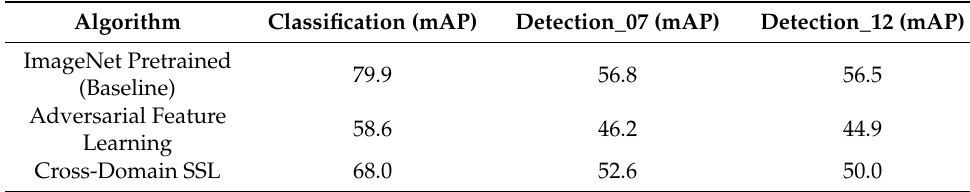
Table 3. Results of transferring learned feature representations from Adversarial Learning pretext tasks for the downstream tasks of classification on the PASCAL VOC 2007 dataset and detection on the PASCAL VOC 2007 and 2012 datasets using a standard AlexNet architecture. Evaluation metrics are included in